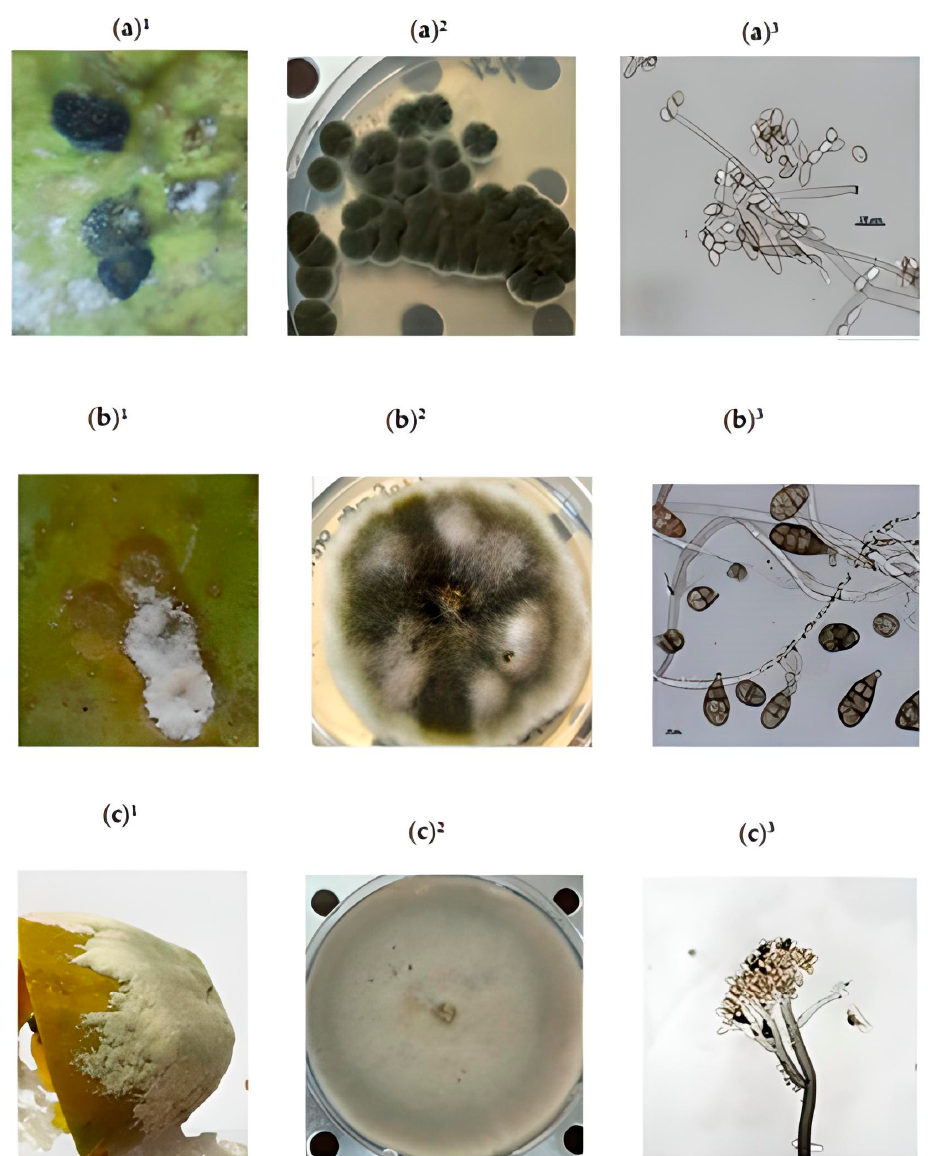
Figure 3. Most recurrent fungal Taxa isolated from naturally infected papaya fruit, identified by their macroscopic and microscopic features. Cladosporium (( a1 ), ( a2 ), ( a3 )), Alternaria (( b1 ), ( b2 ), ( b3 )), and Botrytis cinerea (( c1 ), ( c2 ), ( c3